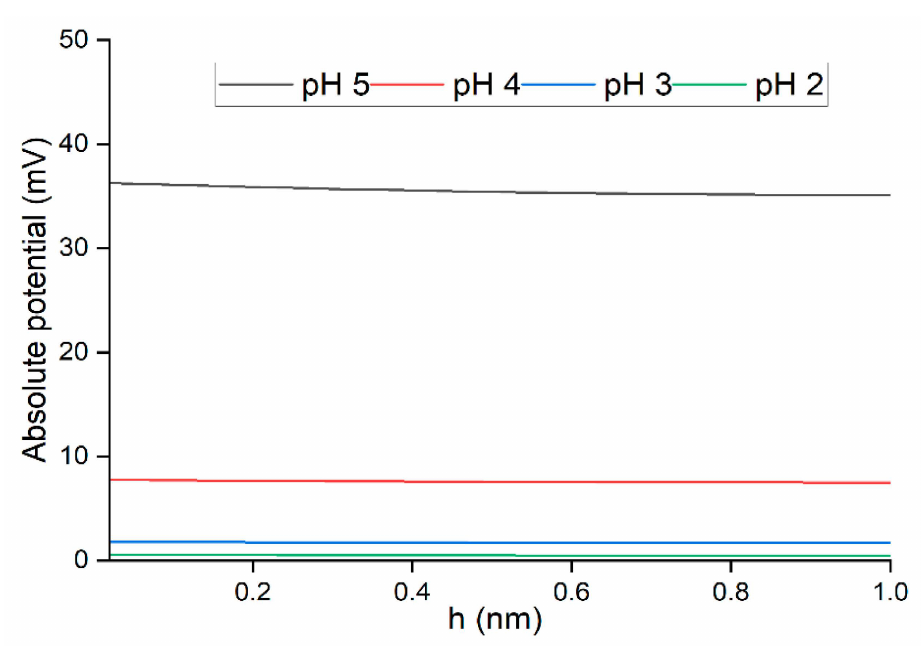
Figure 6. Distribution of double-layer overlap potential (mV) of JPU/GO 0.50 wt% membrane at different